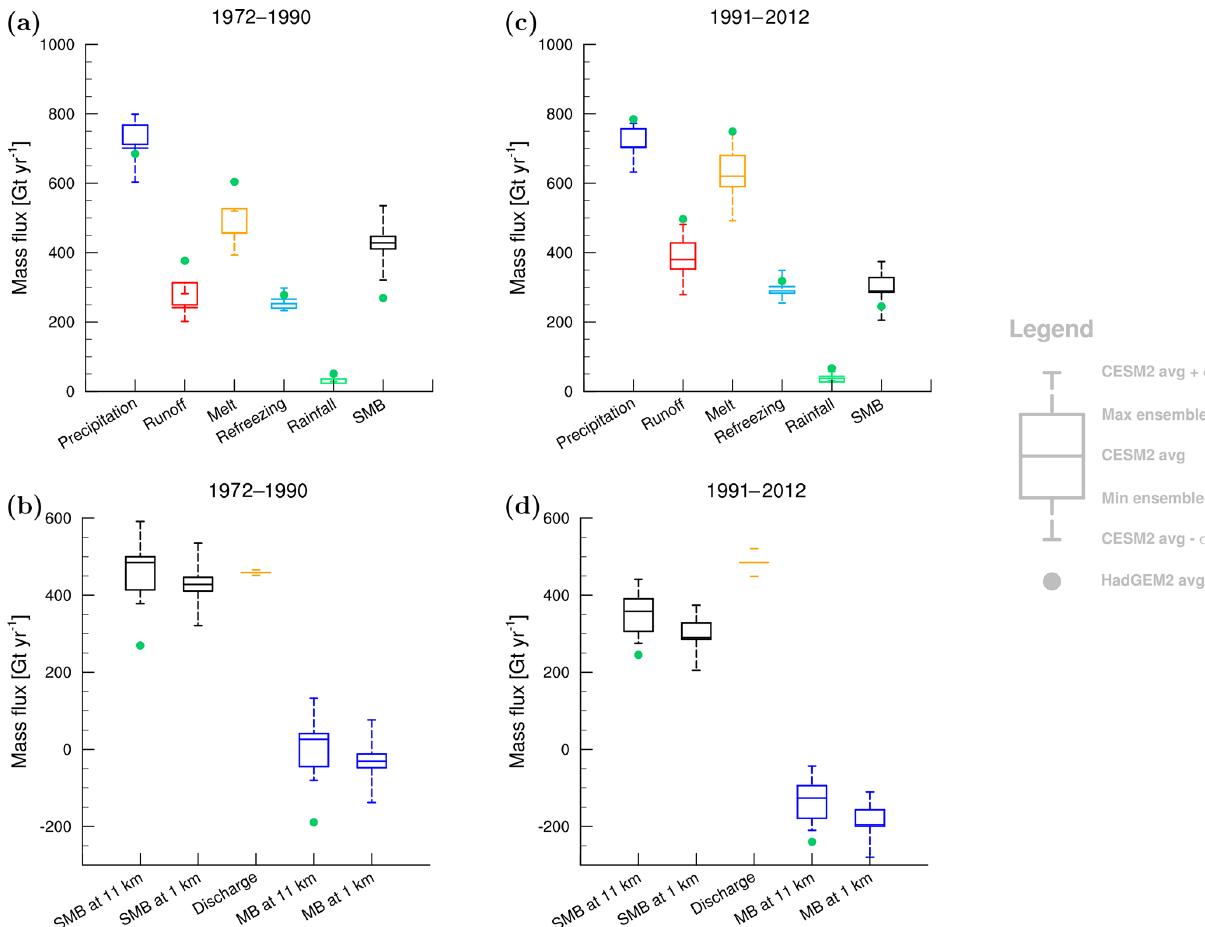
Figure 2. (a) Average GrIS SMB (black) and components at 1km, i.e. total precipitation (blue), runoff (red), melt (orange), refreezing (cyan) and rainfall (green), for the period 1972–1990. (b) Annual mean SMB (black), glacial discharge (orange) (Mouginot et al., 2019) and mass balance (MB = SMB − discharge; blue) at 11 and 1km resolution for the period 1972–1990. ( c and d ) same as ( a and b ) for the period 1991–2012. The green dots represent values from a previous HadGEM2-forced RACMO2.1 simulation. Boxes around the CESM2-forced RACMO2.3p2 mean (horizontal bars) represent the range of modelled estimates from an ensemble of RACMO2 simulations (five at 11km, one at 5.5km, and four at 1km; Tables 1 and 2). The error bars represent 1 standard deviation ( σ ) around the CESM2-forced RACMO2.3p2